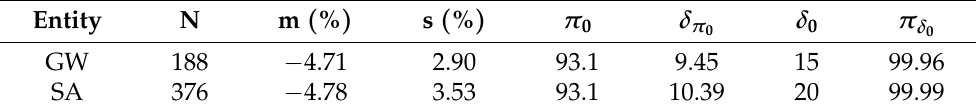
Table 5. Performance for U2 (Class C).